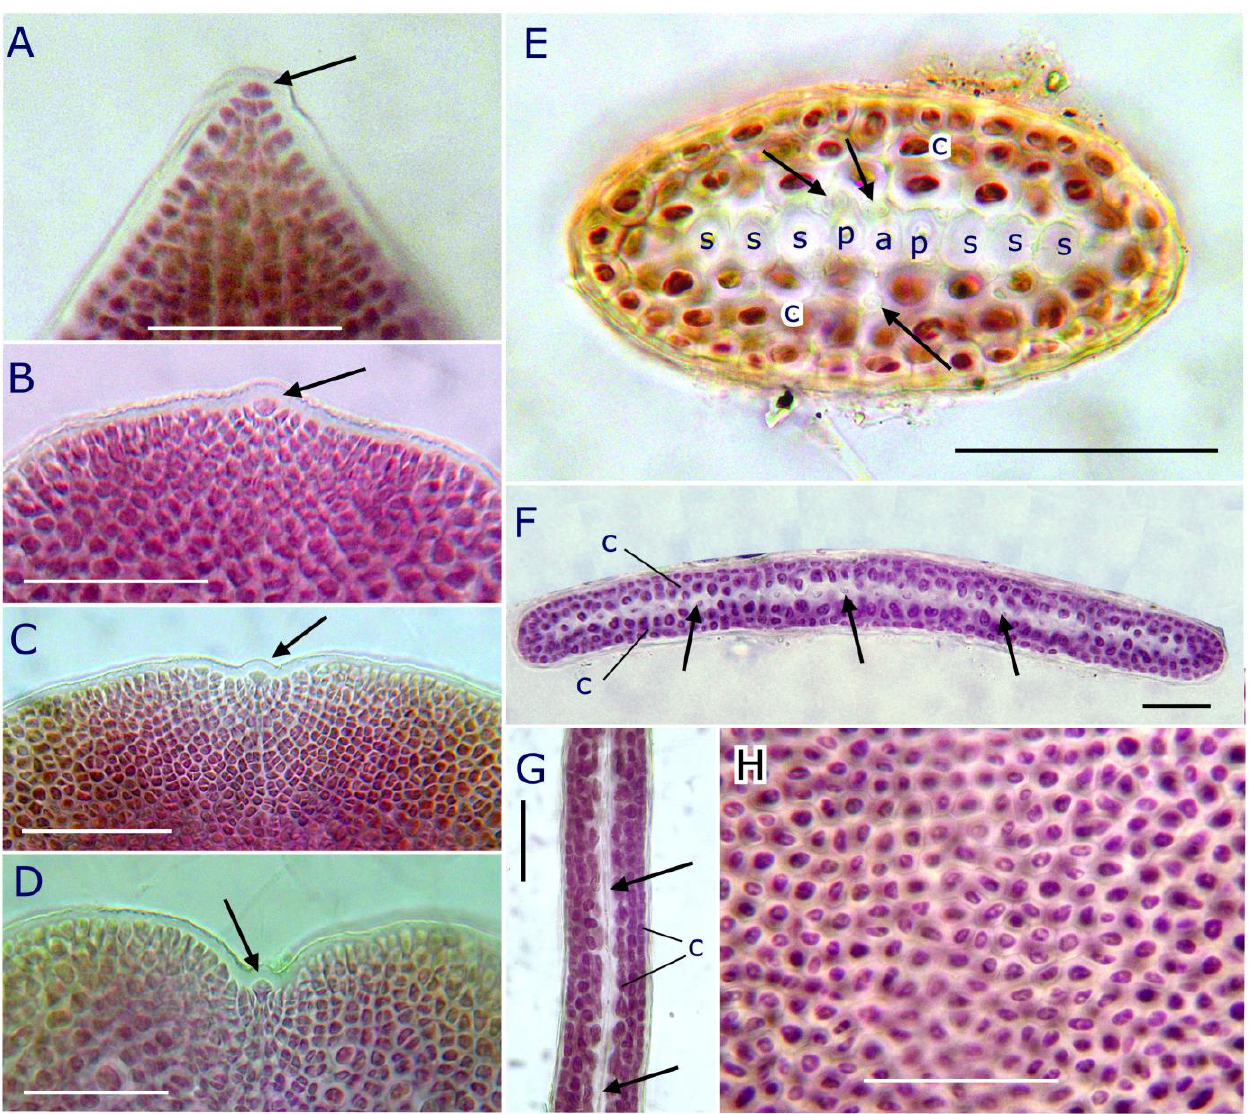
Figure 5. Pterocladiella canariensis sp. nov. ( A ) Attenuated apex with prominent apical cell (arrow); ( B ) obtuse apex showing a slightly protruding apical cell (arrow); ( C ) obtuse apex showing an apical cell (arrow); ( D ) apical cell (arrow) in a depression between cortical lobes; ( E ) transverse section of an erect axis through its attenuated and rounded basal portion showing the central row of non- pigmented thick-walled axial cell (a), periaxial cells (p), and second-order filament cells (s). Three to four layers of cortical cells (c) surround the central row. Some internal rhizoidal filaments (arrows) occur between the inner cortical cells; ( F ) transverse section of the distal flattened erect axis showing a central row of hyaline cells (arrows), and three layers of cortical cells (c); ( G ) longitudinal section of the flattened erect axis showing the axial filament (arrows), surrounded by the cortex; ( H ) surface view of an erect axis showing the irregular arrangement of the outer cortical cells. Scale bar: 50 µm.